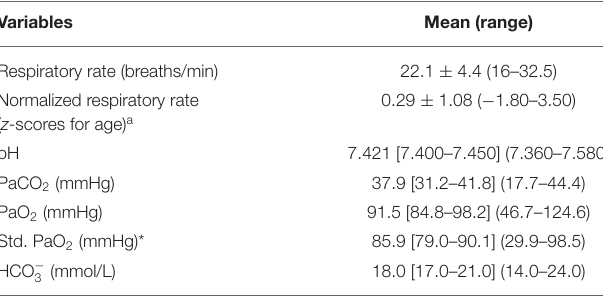
TABLE 3 | Baseline respiratory and arterial blood gas analysis of the examined patients with RTT ( n = 66).